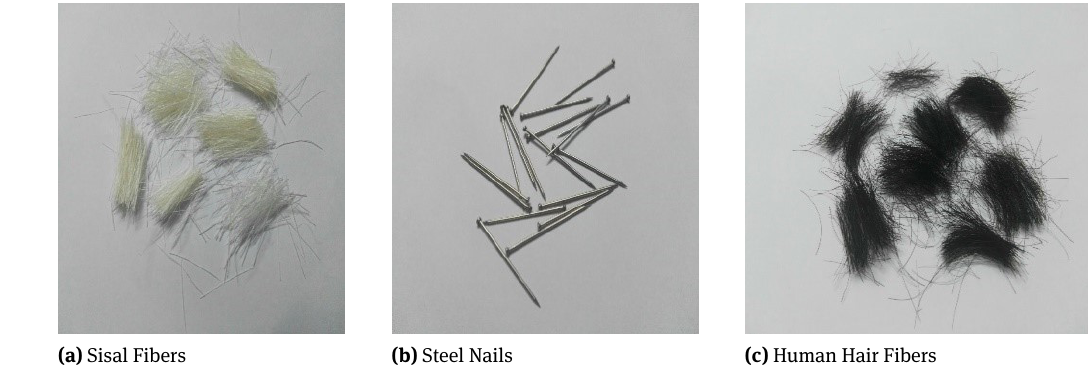
Figure 1: Fibers utilized in this study